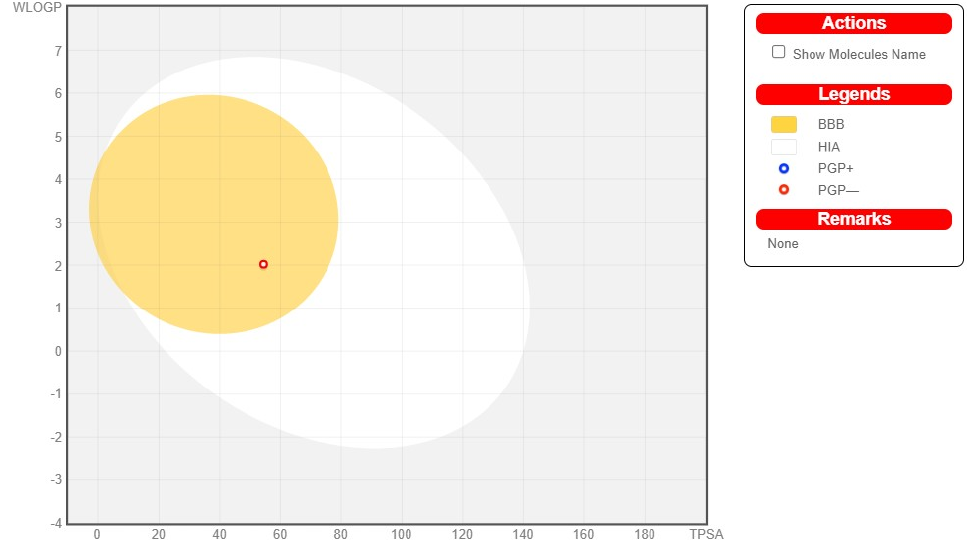
Figure 12. BOILED-Egg diagram for the ligand L1 .